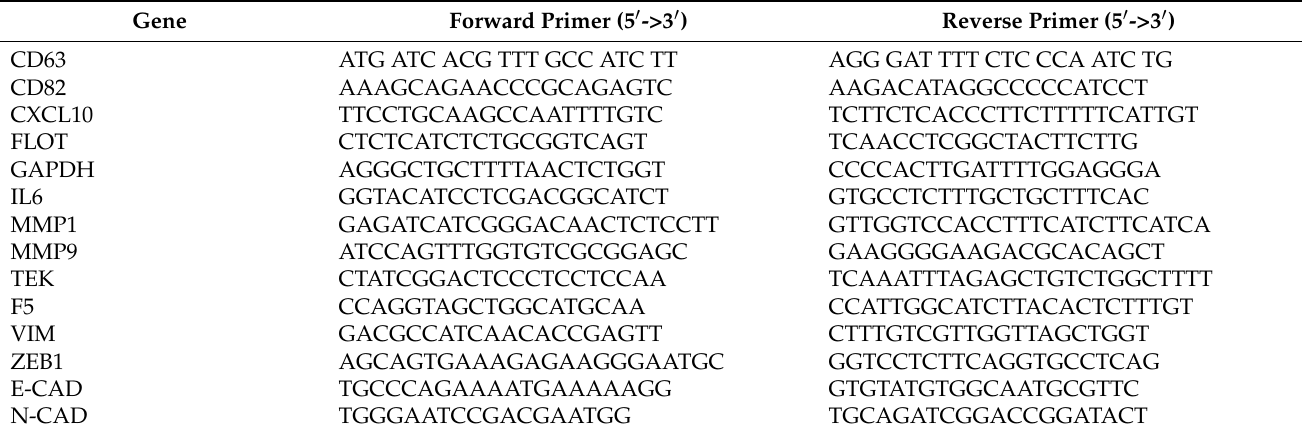
Table 1. Primer pairs for